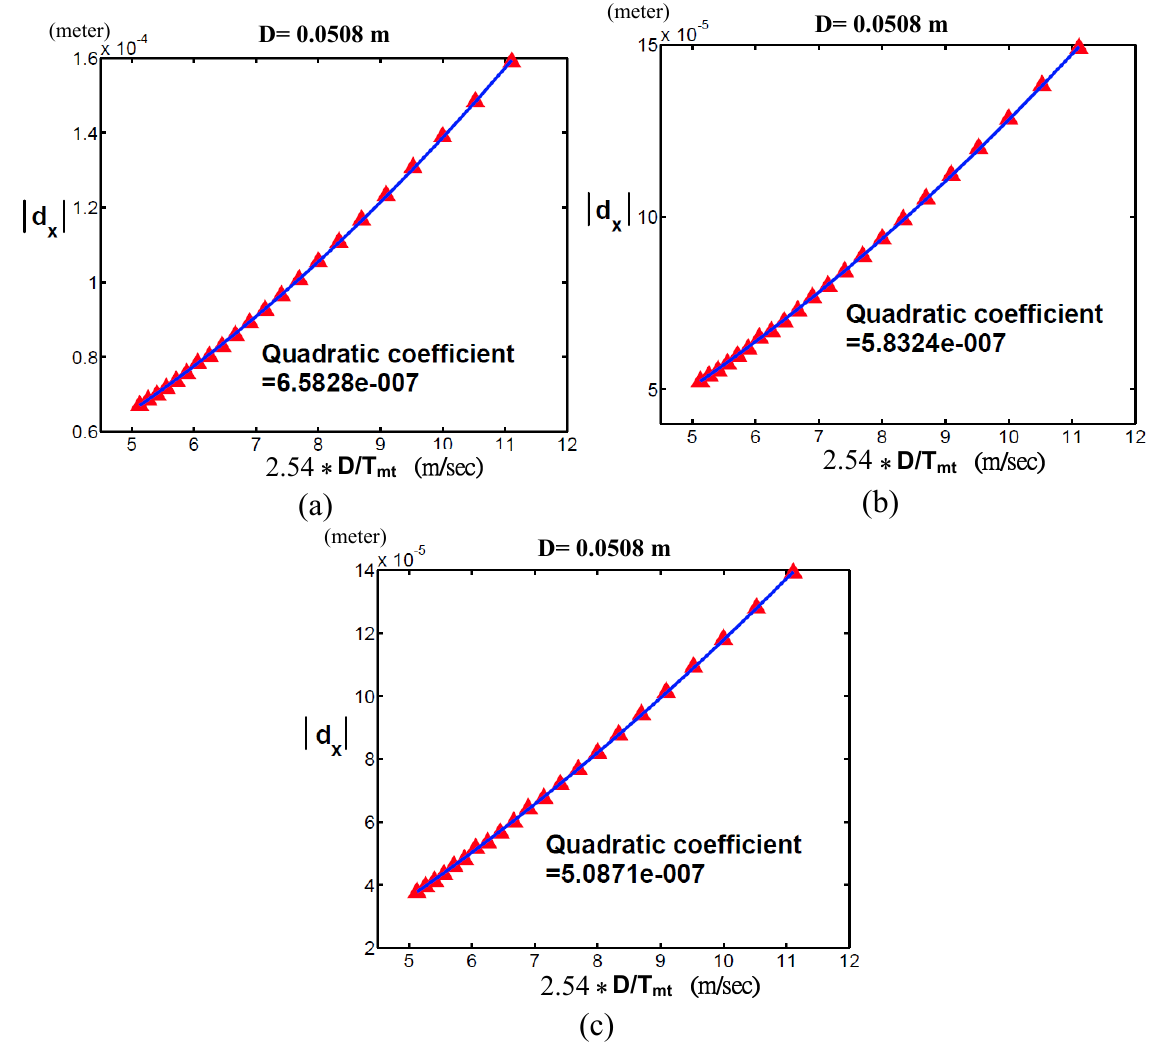
Figure 6. Simulation results of the Cartesian position errors of the end-effector of a PUMA 560 robot along the x -axis ( d ) with respect to the Cartesian velocities ( D/T x D = 0 . 0508 and (cid:52) m was ( a ) − 1% ; ( b ) − 0 . 6% ; ( c ) − 0 . 2% . Red triangles represent the simulation results; the blue curve represents curve